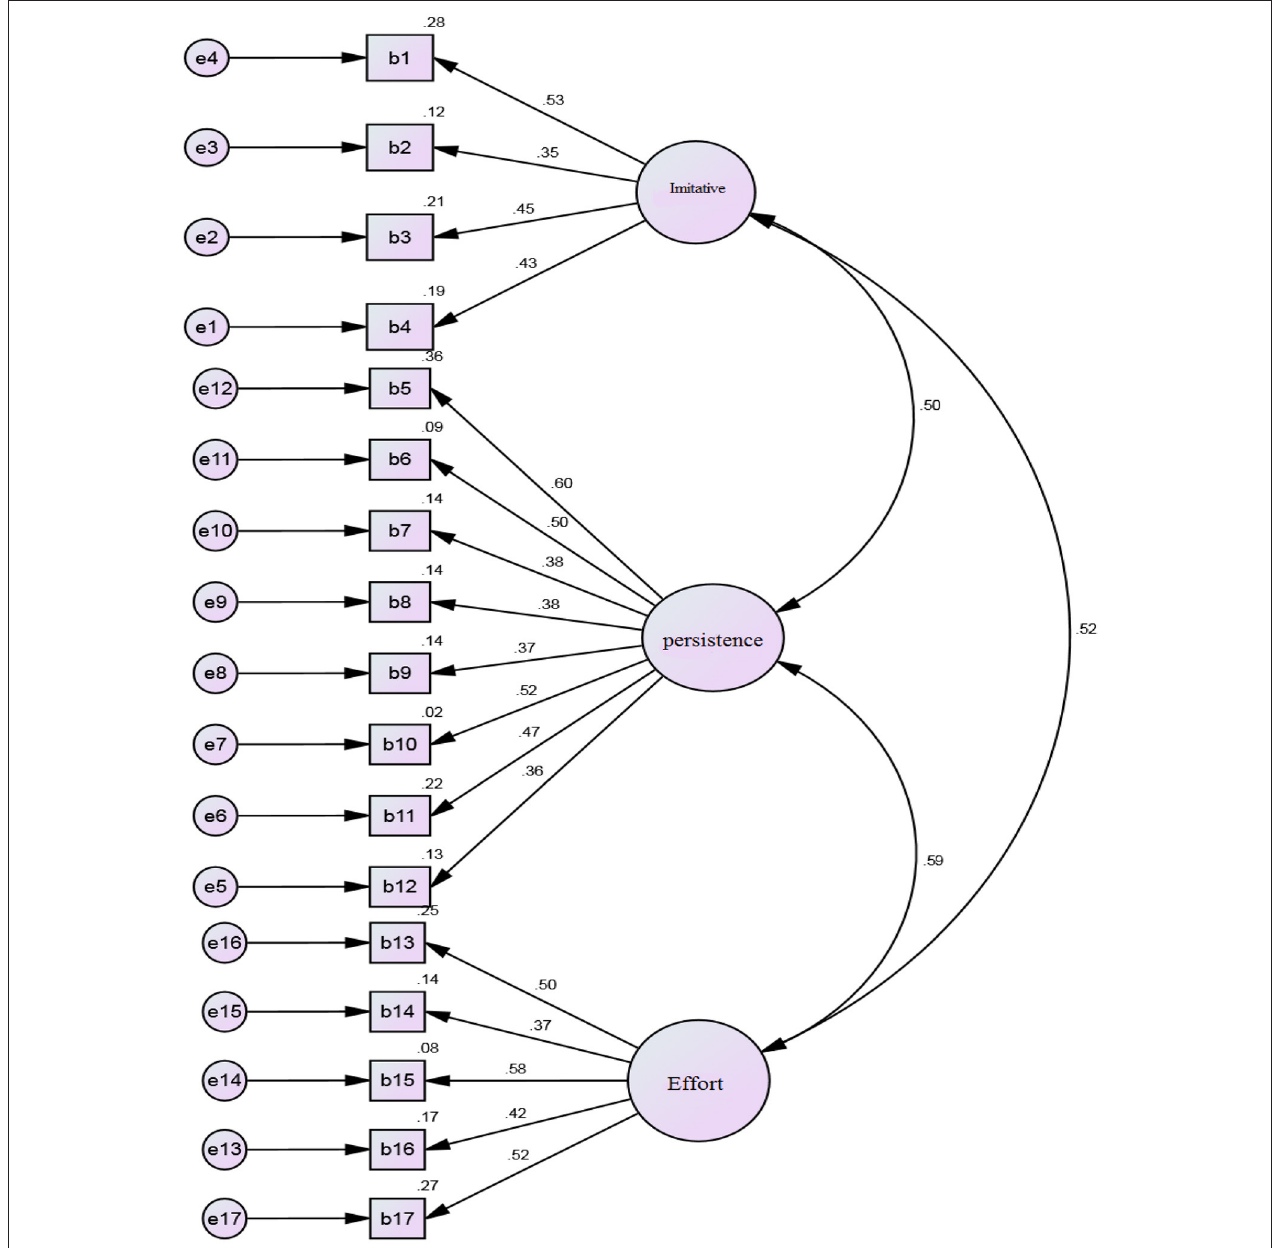
FIGURE 2 | Standardized ( β ) coefficients for CFA analysis and error variance of